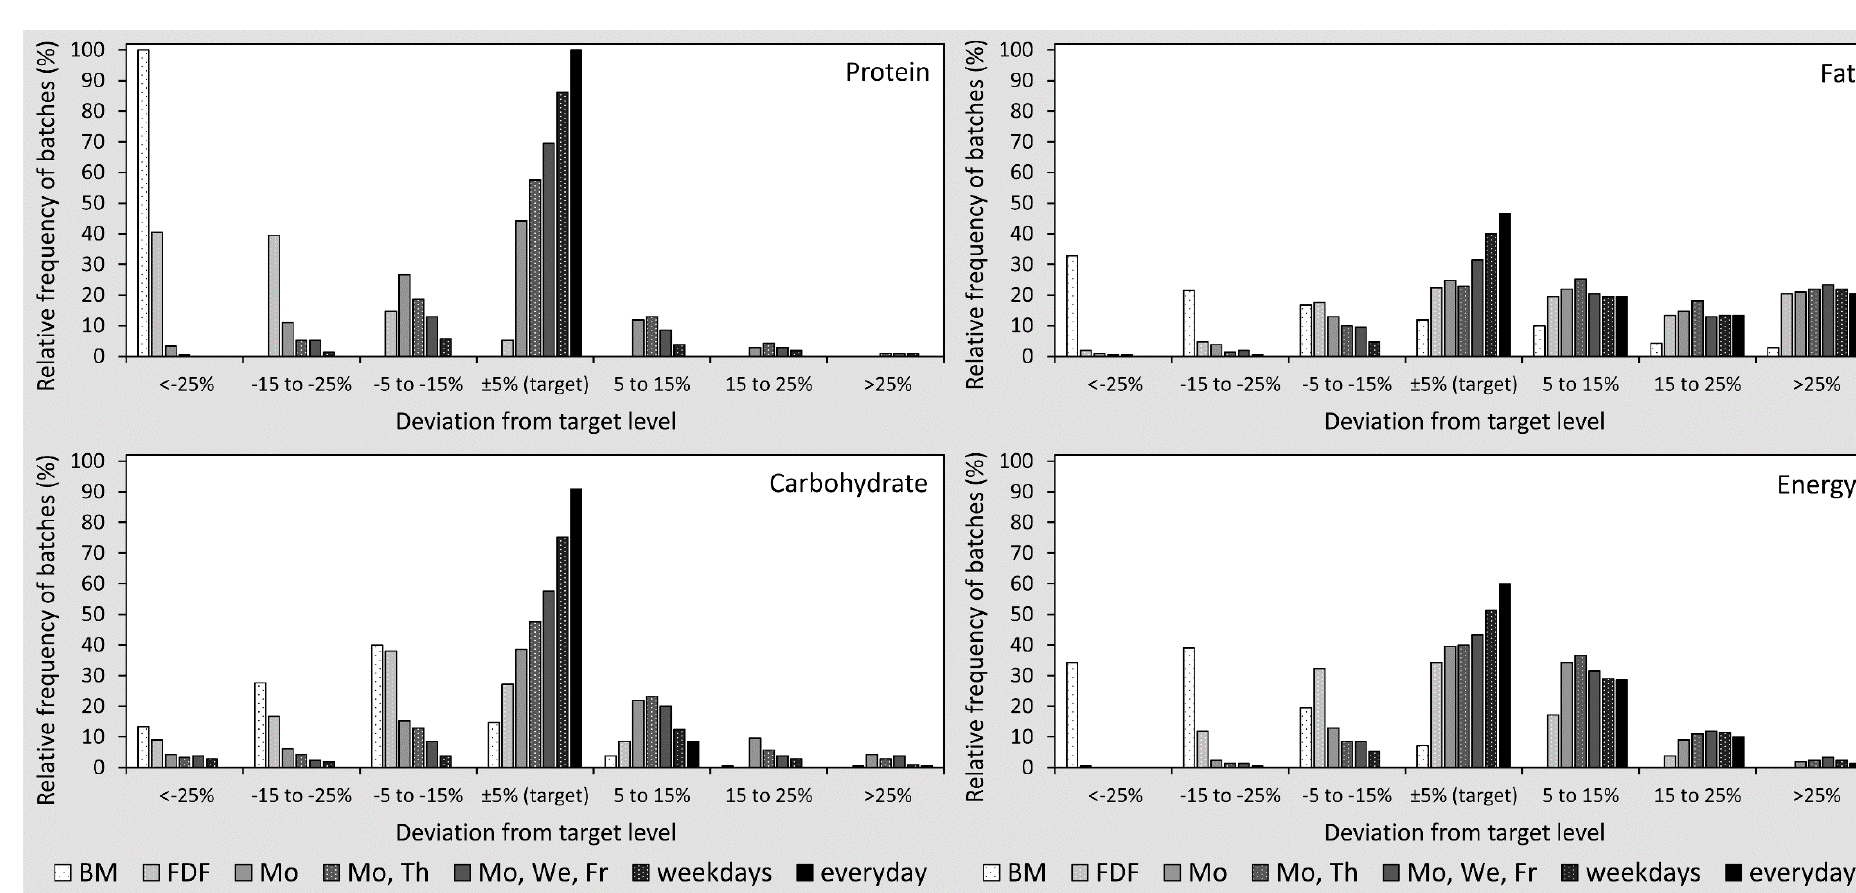
Figure 2. Percentage of samples with the deviation of macronutrients and energy content from ESPHGAN recommendations in single breast milk (BM) batches for native BM, fixed dose fortification (FDF) and target fortification (TFO) (five different schedules). The X -axis shows stratified ranges (deviation from target levels). The sum of relative frequencies per schedule is